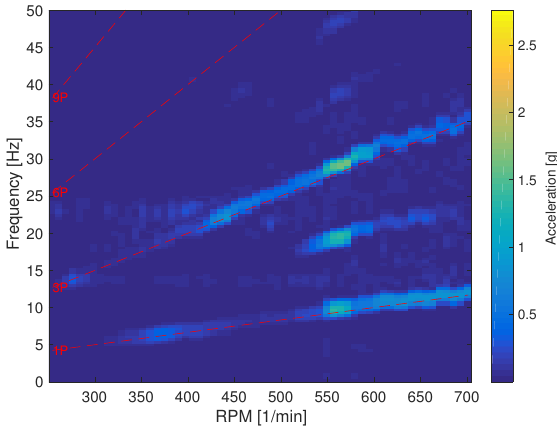
Figure 18. Order of vibration of the tail fin in the Y direction.